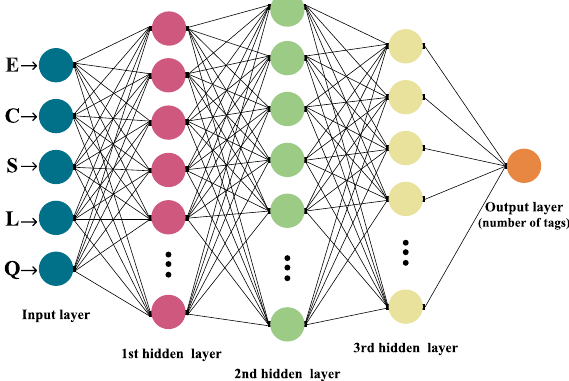
Figure 2. Architecture of the Neural Network